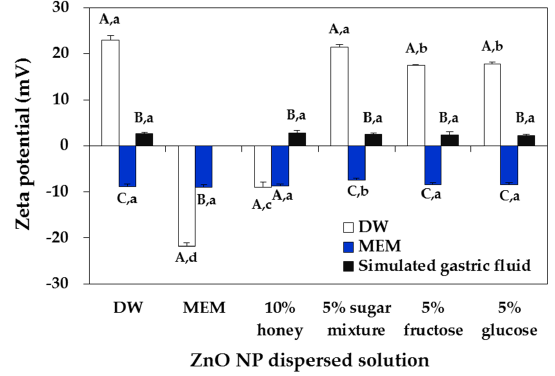
Figure 5. Zeta potentials of ZnO NPs dispersed in DW, minimum essential medium (MEM), or different saccharide solutions for 1 h and then, measured in biological fluids (MEM and simulated gastric fluid) or DW as a control. Different capital letters (A–C) indicate significant differences between DLS measured biological fluids (DW, MEM and simulated gastric fluid) ( p < 0.05). Different lower-case letters (a–c) indicate significant differences between NP dispersed solutions (DW, MEM, 10% honey, 5% sugar mixture, 5% fructose and 5% glucose) ( p < 0.05). 5% sugar mixture consists of 5% fructose, 5% glucose, 5% sucrose and 5% maltose. The solubility of NPs was not affected by honey or sugar mixture solutions versus DW, showing 0.7 ± 0.1%, 0.2 ± 0.1% and 0.2 ± 0.1% solubilities in 10% honey, 5% sugar mixture and DW, respectively.